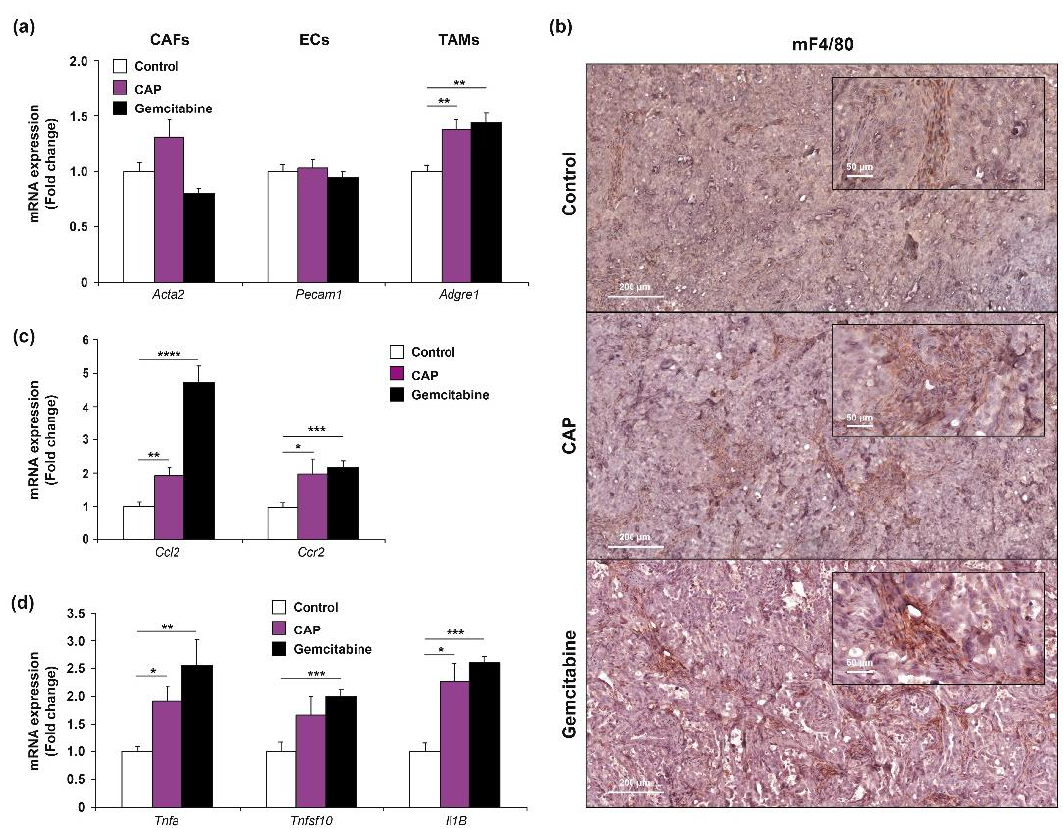
Figure 8. ( a ) Changes in mRNA expression of cell type markers ( Acta2 / α -SMA, a marker of cancer-associated fibroblasts CAFs, Pecam1 / CD31, a marker of endothelial cells (EC) and Adgre1 / F4 / 80, a marker of tumor-associated macrophages (TAM) in control (white bars), CAP (purple bars) and gemcitabine (black bars) treated xenograft tumors. ( c ) Representative IHC staining of F4 / 80 in the same tumors. Magnification × 250 (inserts × 1000). Scale: 200 µ m. ( b ) Changes in mRNA expression of Ccl2 / Mcp1 and Ccr2 (c) in control (white bars), CAP (purple bars) and gemcitabine (black bars) treated xenograft tumors. ( d ) Changes in mRNA expression of pro-apoptotic cytokines ( Tnfa / Tnf α , Tnfsf1 / Trail and Il1b / Il1 β ) in control (white bars), CAP (purple bars), and gemcitabine (black bars) treated xenograft tumors. Values are expressed as means ± SEM. *, p < 0.05; **, p < 0.01; ***, p < 0.001; ****, p < 0.0001; compared with control tumors.